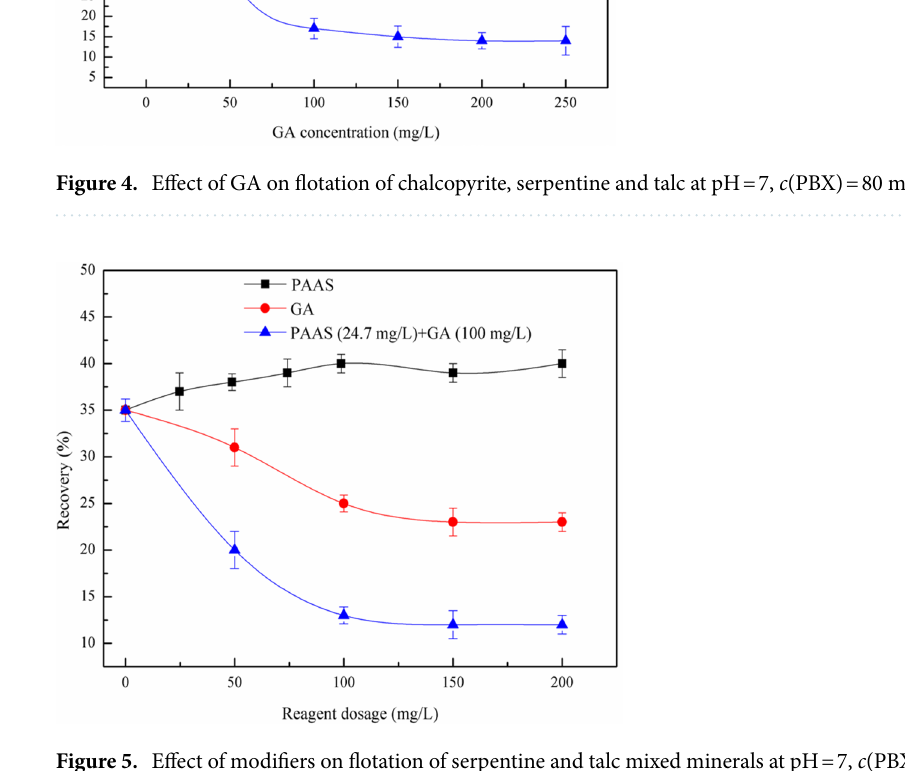
Figure 5. Effect of modifiers on flotation of serpentine and talc mixed minerals at pH = 7, c (PBX) = 80 mg/L, talc: − 150 + 37 μm, serpentine: − 10